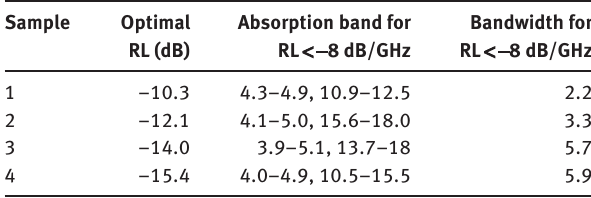
Figure 6: Reflection loss of double-layer cement samples with dif- ferent replacement level of FA in matching layer. Table 3: Detailed data of double-layer cement composites with dif- ferent replacement levels of FA in the matching